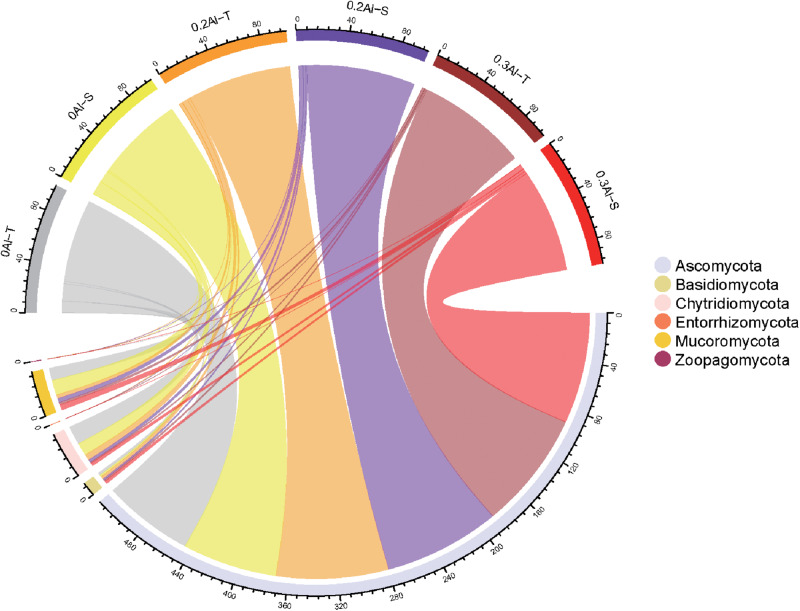
The relative abundance of rhizosphere fungi at the phylum level was detected in all soil samples. The color of the top half of the outer ring represents the corresponding soil sample group. The lower half of the outer ring is colored to represents different fungi at the phylum level. The thickness of lines was proportional to the relative abundance of rhizosphere fungi at the phylum level. Al-T: Al-tolerant soybean genotypes; Al-S: Al-sensitive soybean genotypes.